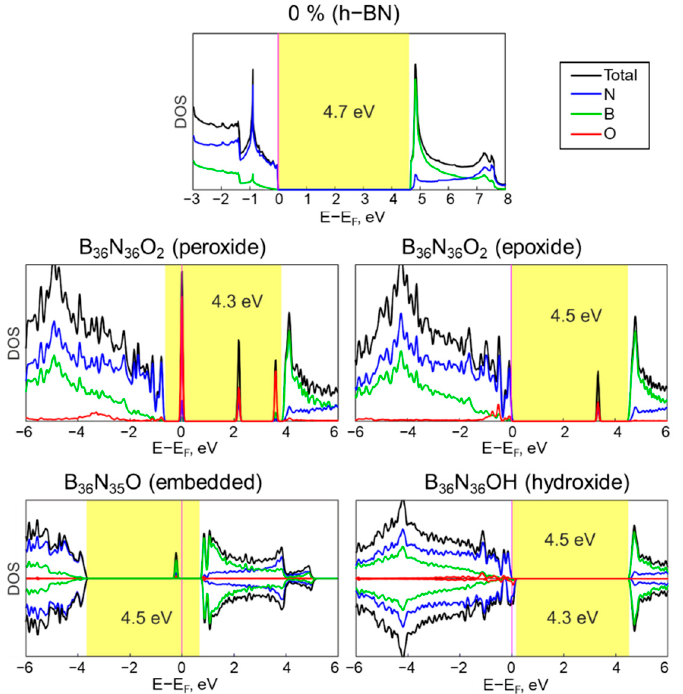
Figure 3. Density of electronic states of B x N y O z structures. Boron, nitrogen, and oxygen contributions as marked by green, blue, and red colors, respectively. The band gap is shaded by yellow. The Fermi level is vanished and marked by vertical line.